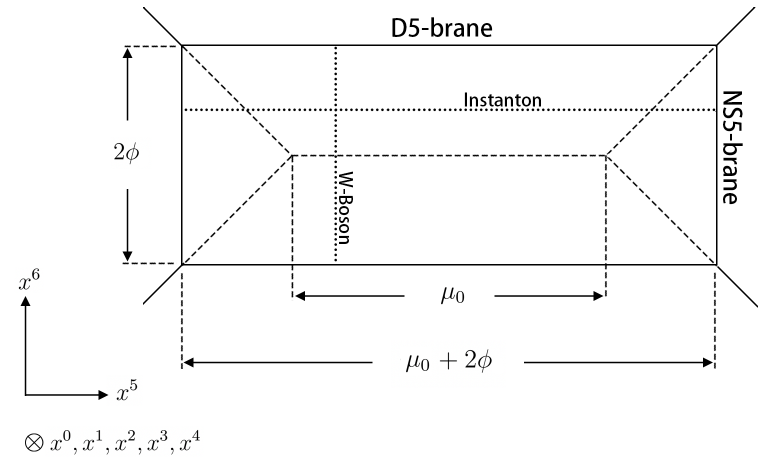
Figure 1 . F0 case: brane web for 5d pure Sp(1) gauge theory with zero θ -angle.